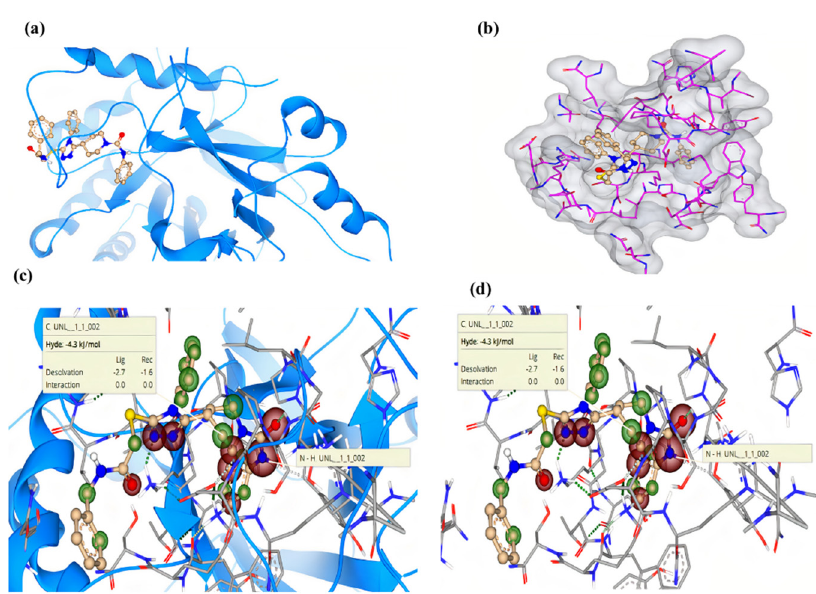
Figure 6. SeeSAR analysis of potent derivative 7d in the pocket of AKR1B1 ( a , b ) Ligand in active pocket of targeted protein. ( c , d ) Docked conformations with coronas. Unfavorable aspects are indicated by red coronas, while positive contributions are indicated by green coronas, and colorless coronas indicate no structural component contribution.